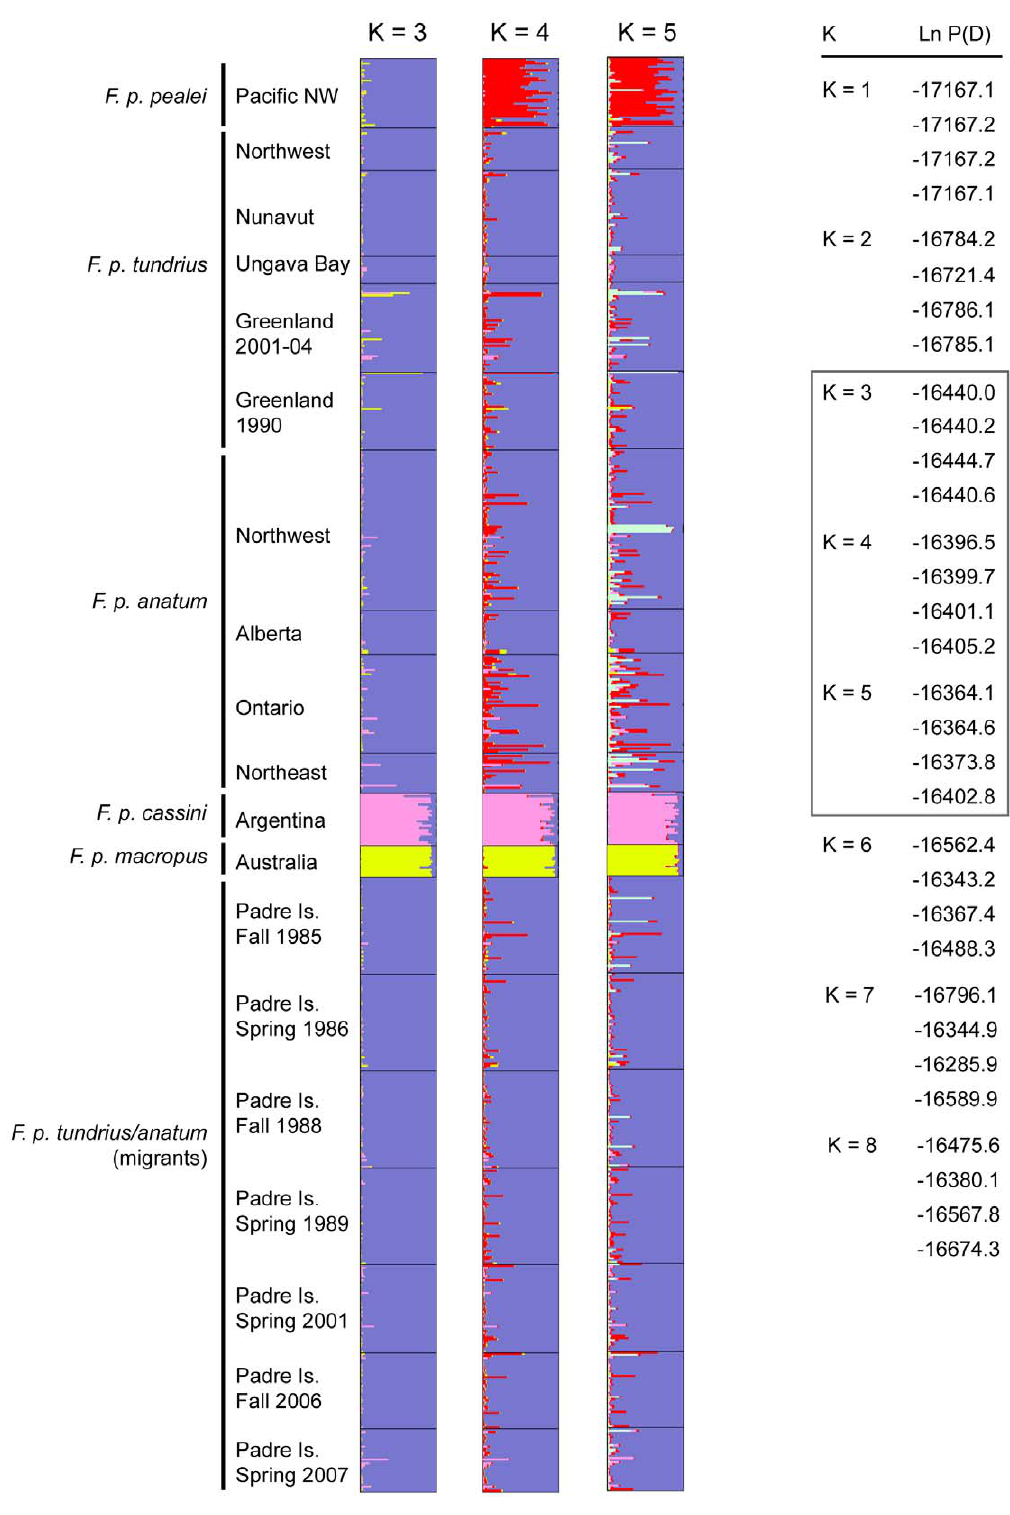
Figure 2. Results from S TRUCTURE analysis for all sampled peregrine falcon populations. (A) Assignment of individuals to K=3 to 5 inferred clusters based on 11 microsatellite loci. Colors indicate different inferred clusters and their magnitude represents the posterior probability that the individual belongs to a particular cluster. (B) Estimated log probability values [Ln (P(D)] for each run for K =1 to 8. The box highlighting K =3 to 5 indicates the lowest values of K with the highest likelihood values. These results remained similar after excluding F. p. cassini and macropus from the analysis (data not shown).